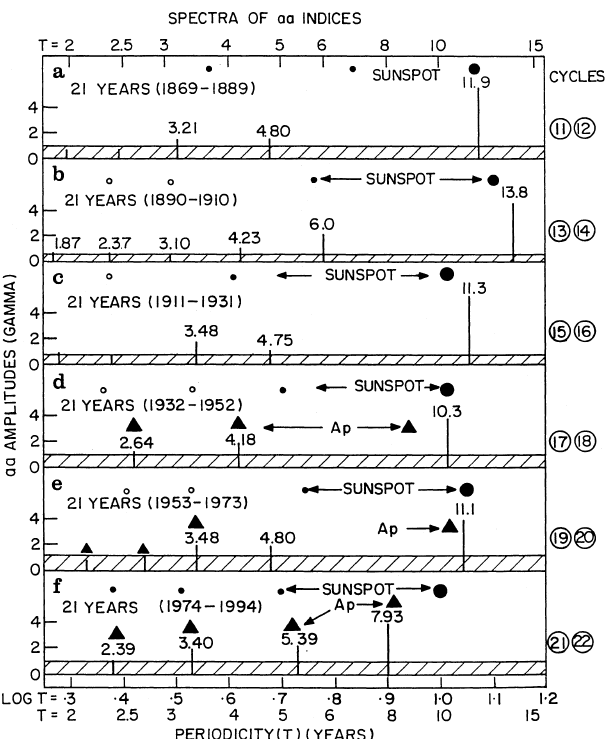
Fig. 4a–f. Spectra for aa series for 1869–1889, 1890–1910, 1911–1931, 1932–1952, 1953–1973, 1974–1994, 21 y each. Solid and open circles show peaks for sunspots and solid triangles for